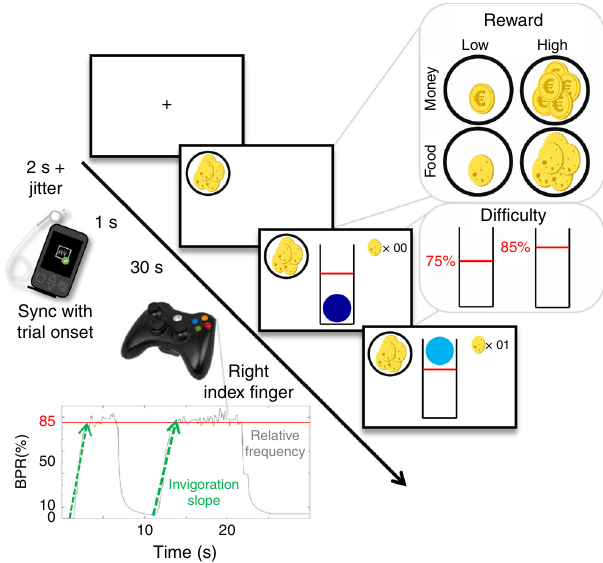
Fig. 1 Schematic summary of the effort allocation task. First, a fi xation cross is shown. The trial starts in sync with the stimulation and the reward cue is shown for 1 s. During the effort phase, participants have to keep a ball above the red line by vigorously pressing a button with their right index fi nger to earn rewards. As task conditions, we manipulated reward type (food vs. money), reward magnitude (low vs. high), and dif fi culty (easy vs. hard). The inset shows a representative time series in one high-dif fi culty trial depicting effort output as button press rate, BPR, in % relative to the maximum frequency of the participant. Invigoration slopes were estimated to capture how quickly participants ramp up their effort during a trial to obtain the reward at stake. Effort maintenance was estimated by taking the average relative frequency on the